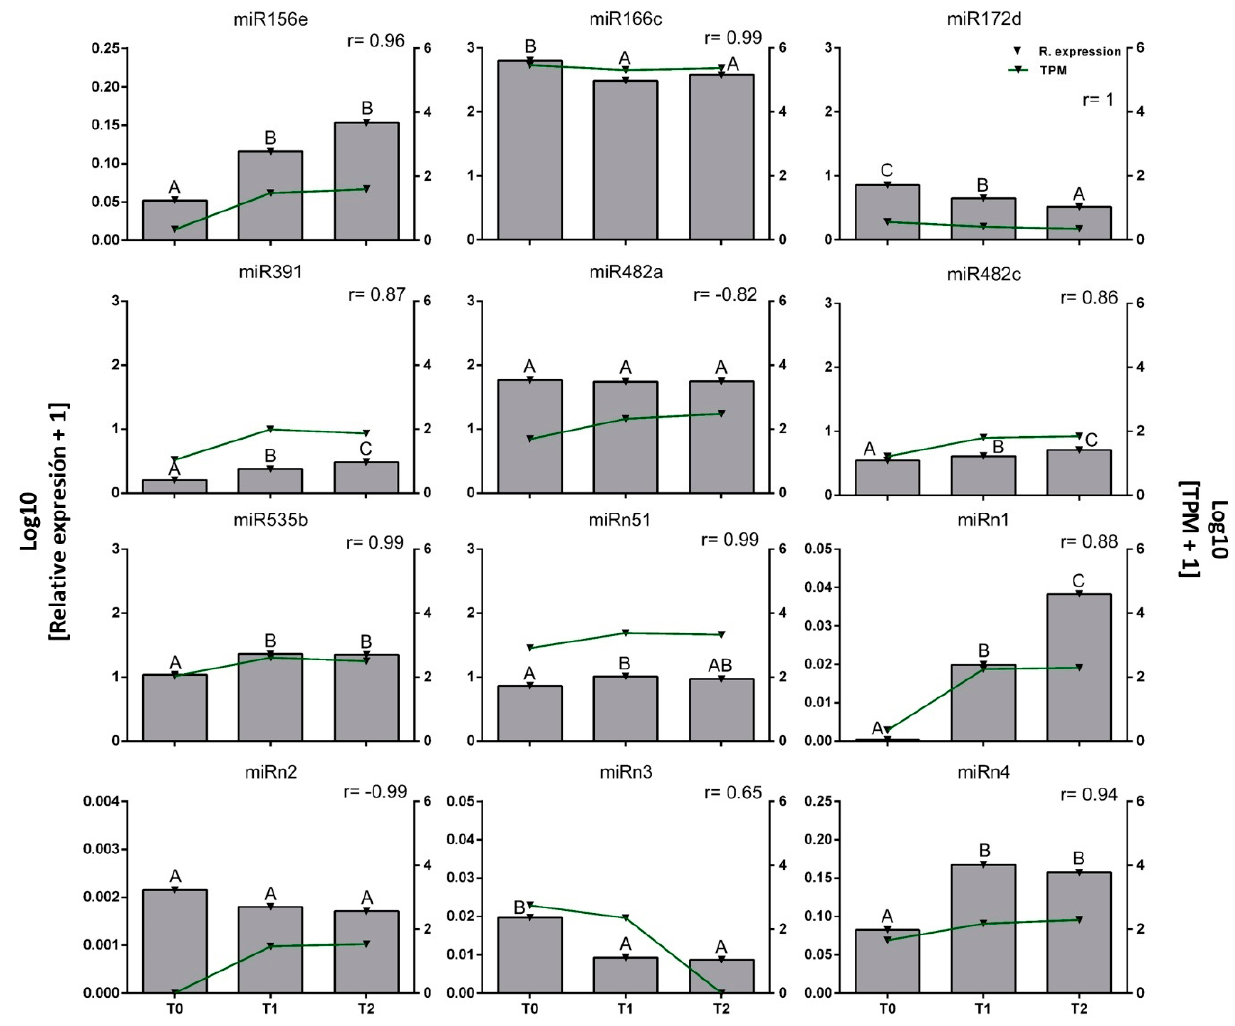
Figure 4. Validation of miRNA expression. The samples from T0 (0 CH), T1 (853 CH), and T2 (909 CH) stages were compared between NGS (lines) and qRT-PCR (bars) determinations. Means with different letters among stages show high statistical significance ( p -value ≤ 0.05) of three technical replicates. The value of r corresponds to the Pearson’s correlation between the relative expression for qRT-PCR and normalized reads from NGS.